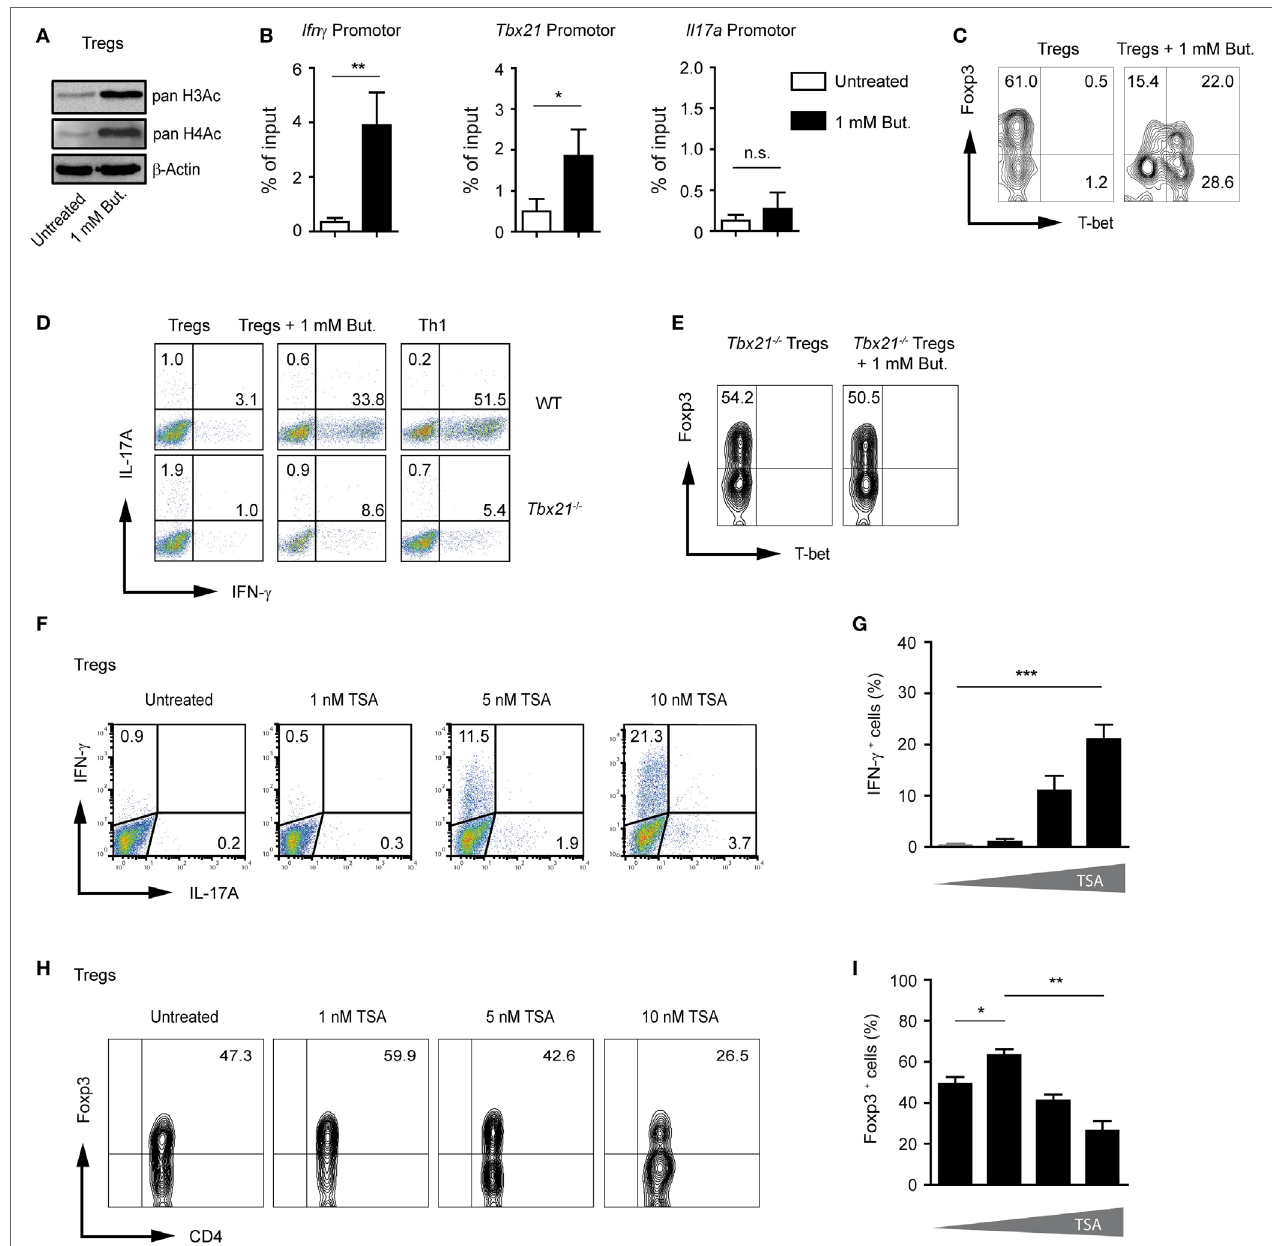
FigUre 3 | Butyrate induces changes in H3 acetylation at the Ifng and Tbx21 locus during the differentiation of regulatory T cells (Tregs). (a) Western blot analysis showing the acetylation of histones H3 and H4 in the presence of 1 mM butyrate in CD4 + T cells cultured under Treg-inducing conditions for 3 days. Three similar experiments were performed. (B) Analysis of acetylated state of H3 at the promoter region of Ifng , Tbx21 , and Il17a in T cells cultured under Treg-inducing conditions and treated with 1 mM butyrate for 3 days. Chromatin immunoprecipitation assay was performed using an anti-acetyl-H3 antibody. Data are average of two independent experiments; * P = 0.01–0.05, ** P = 0.001–0.01, and n.s., not significant. (c) CD4 + T cells were differentiated into Tregs with 1 ng/ml TGF- β 1 in the presence or absence of 1 mM butyrate. On day 3 of the cell culture, T-bet and Foxp3 expression was measured by FACS analysis. (D) Representative dot blots showing IFN- γ and IL-17A expression in wild-type (WT) and Tbx21 − / − CD4 + T cells cultured under Treg- or Th1-inducing conditions for 3 days in the presence of 1 mM of sodium butyrate. One of three similar experiments is shown. (e) Representative dot blots showing T-bet and Foxp3 expression in Tbx21 − / − CD4 + T cells cultured under Treg-inducing conditions with 1 ng/ml TGF- β 1 in the presence 1 mM butyrate. (F,g) The frequency of IFN- γ + and IL17A + cells was determined on day 3 during the differentiation of Tregs in the presence of indicated TSA concentrations. Data (g) represent the mean ± SEM; *** P < 0.001. Two experiments were performed. (h,i) The percentage of Foxp3 + CD4 + T cells was determined on day 3 during the differentiation of Tregs in the presence of indicated TSA concentrations. Results in (i) represent the mean ± SEM of two experiments; * P = 0.01–0.05, ** P =